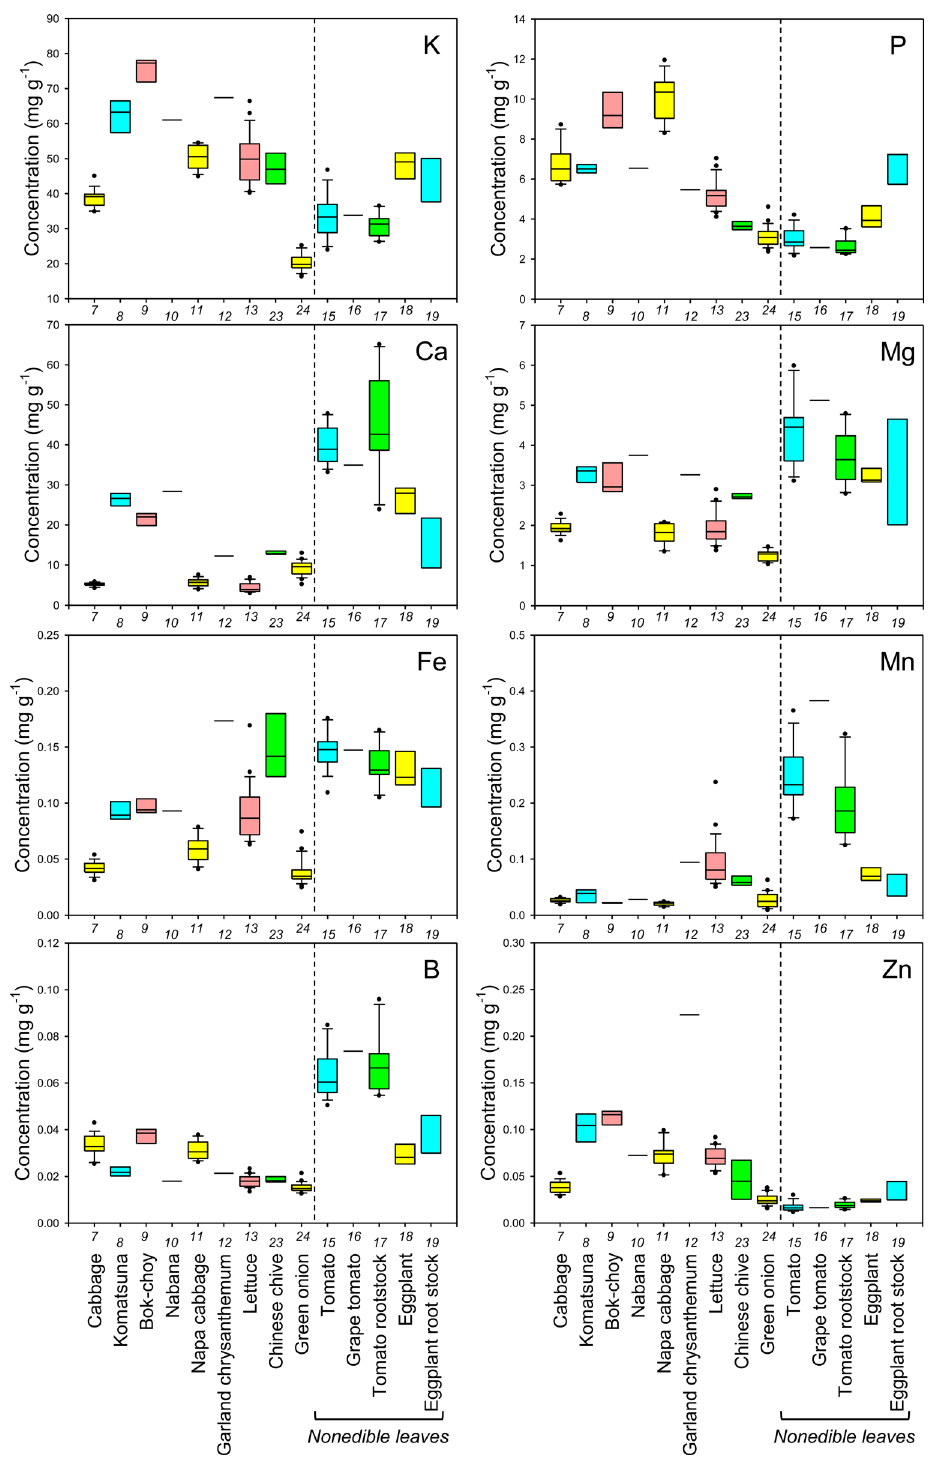
Fig 1. Boxplots showing the concentration of K, P, Ca, Mg, Fe, Mn, B, and Zn in leaves of various crop species. Concentrations in nonedible leaves are also shown. Numbers in x-axis indicate the species number in Table